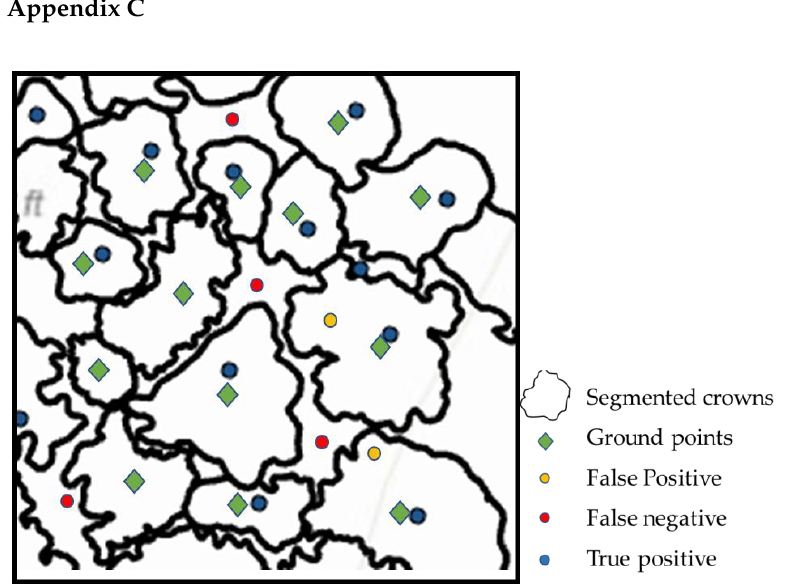
Figure A2. Illustration for calculating the TP, FP, and FN from the segmented